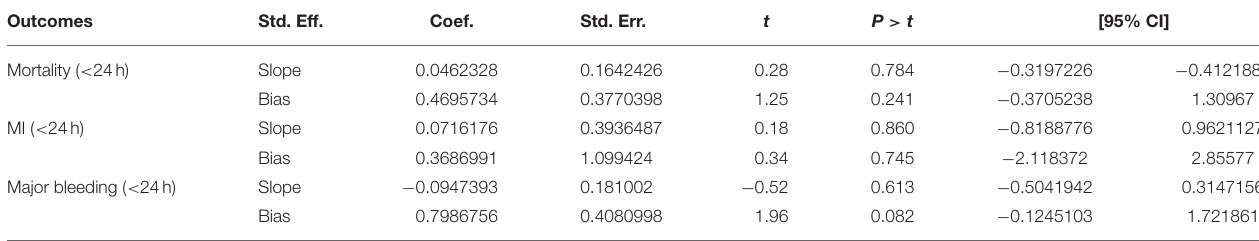
TABLE 3 | Egger’s test of publication bias for mortality, MI, and major bleeding. Outcomes Std. Eff. Coef. Std. Err. P > t [95% CI] Mortality ( < 24h)